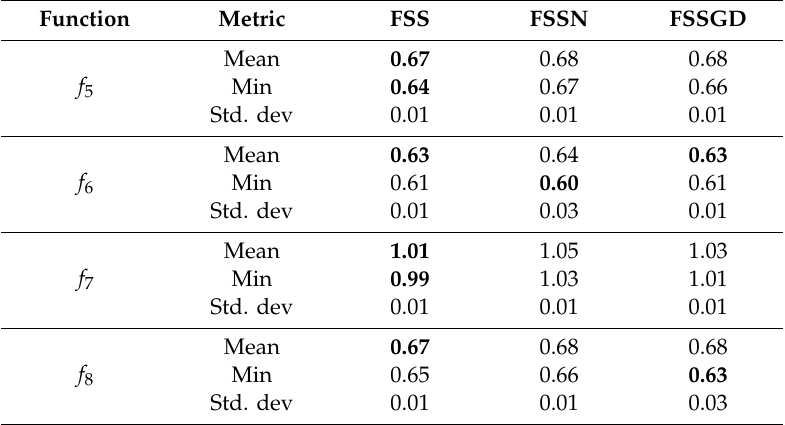
Table 5. Time benchmarks of 2-dimensional test functions listed in Table 1.